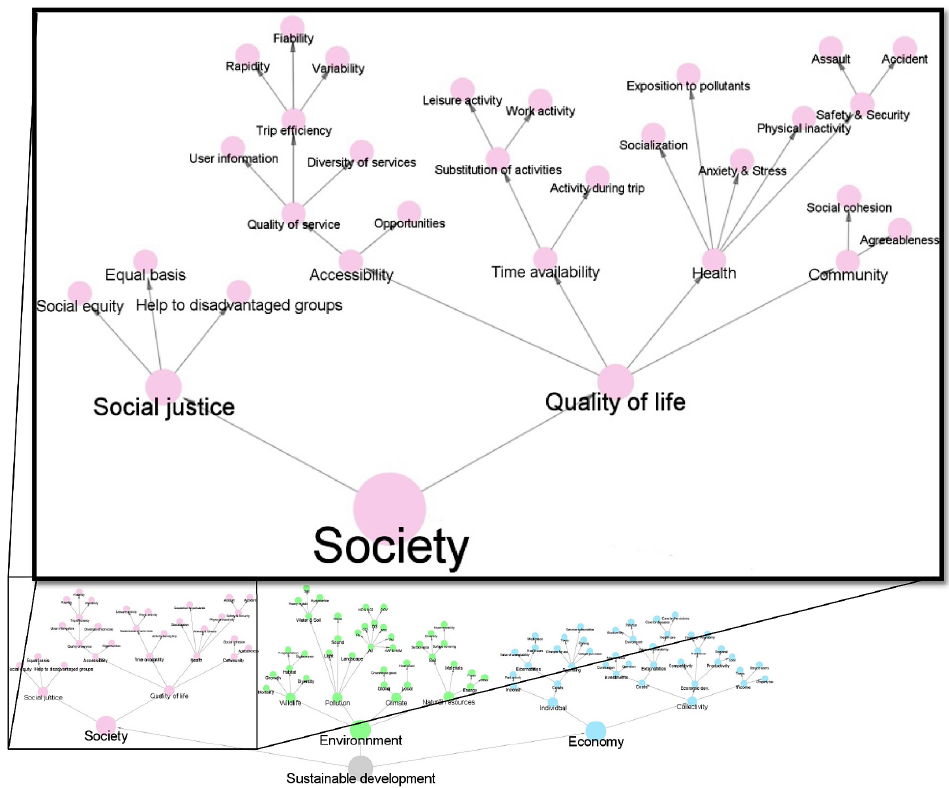
Fig. 1. The Octopus, focused on the social dimension (Sioui